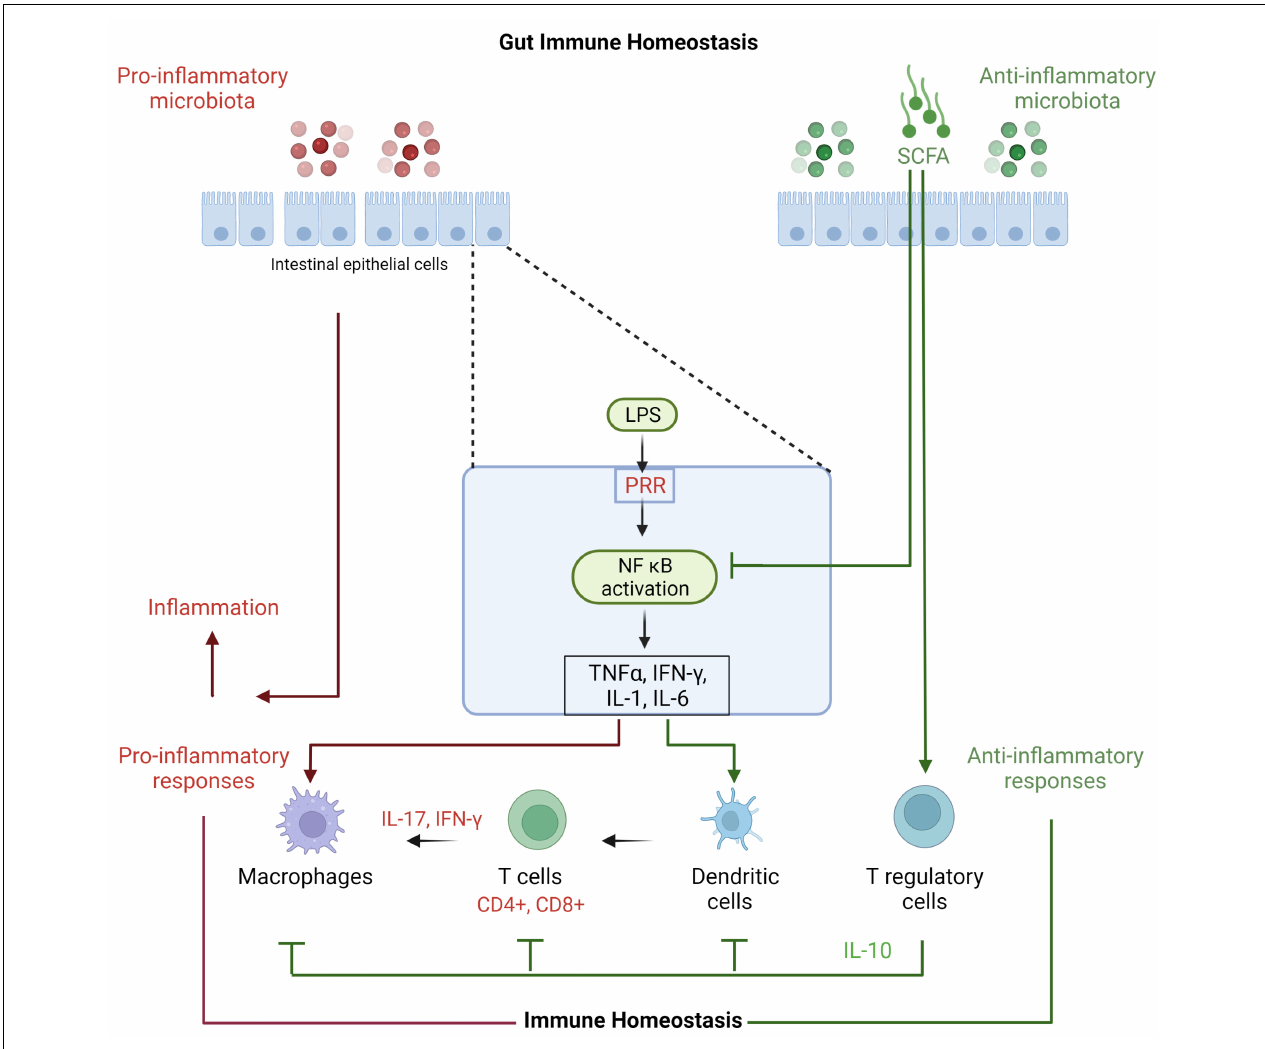
FIGURE 2 | Effects of microbiota on gut immune homeostasis. Gut microbiota and their metabolites interact with gut epithelial cells through PRR such as membranous Toll-like receptors and cytoplasmic NOD-like receptors. The subsequent inflammatory mediators activate other immune components. The gut immune system protects the epithelial lining and responds to incursions with different immune cells including dendritic cells, macrophages, CD4 and CD8 T cells and their cytokines like gamma interferon and IL-17 to proceed inflammation. IL-17 is important as it stimulates tight junction and mucin proteins and improves gut integrity and function. Longer and exaggerated inflammation is not helpful and counterproductive. Thus, T reg cells with the help of its key IL-10 cytokine control these cells and maintains immune